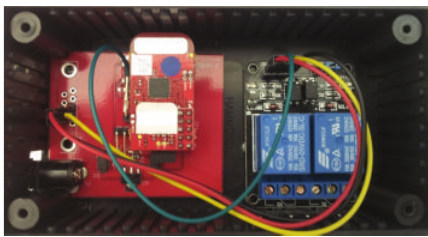
Figure 8: ZigBee-based local controller for ClipperCreek charging